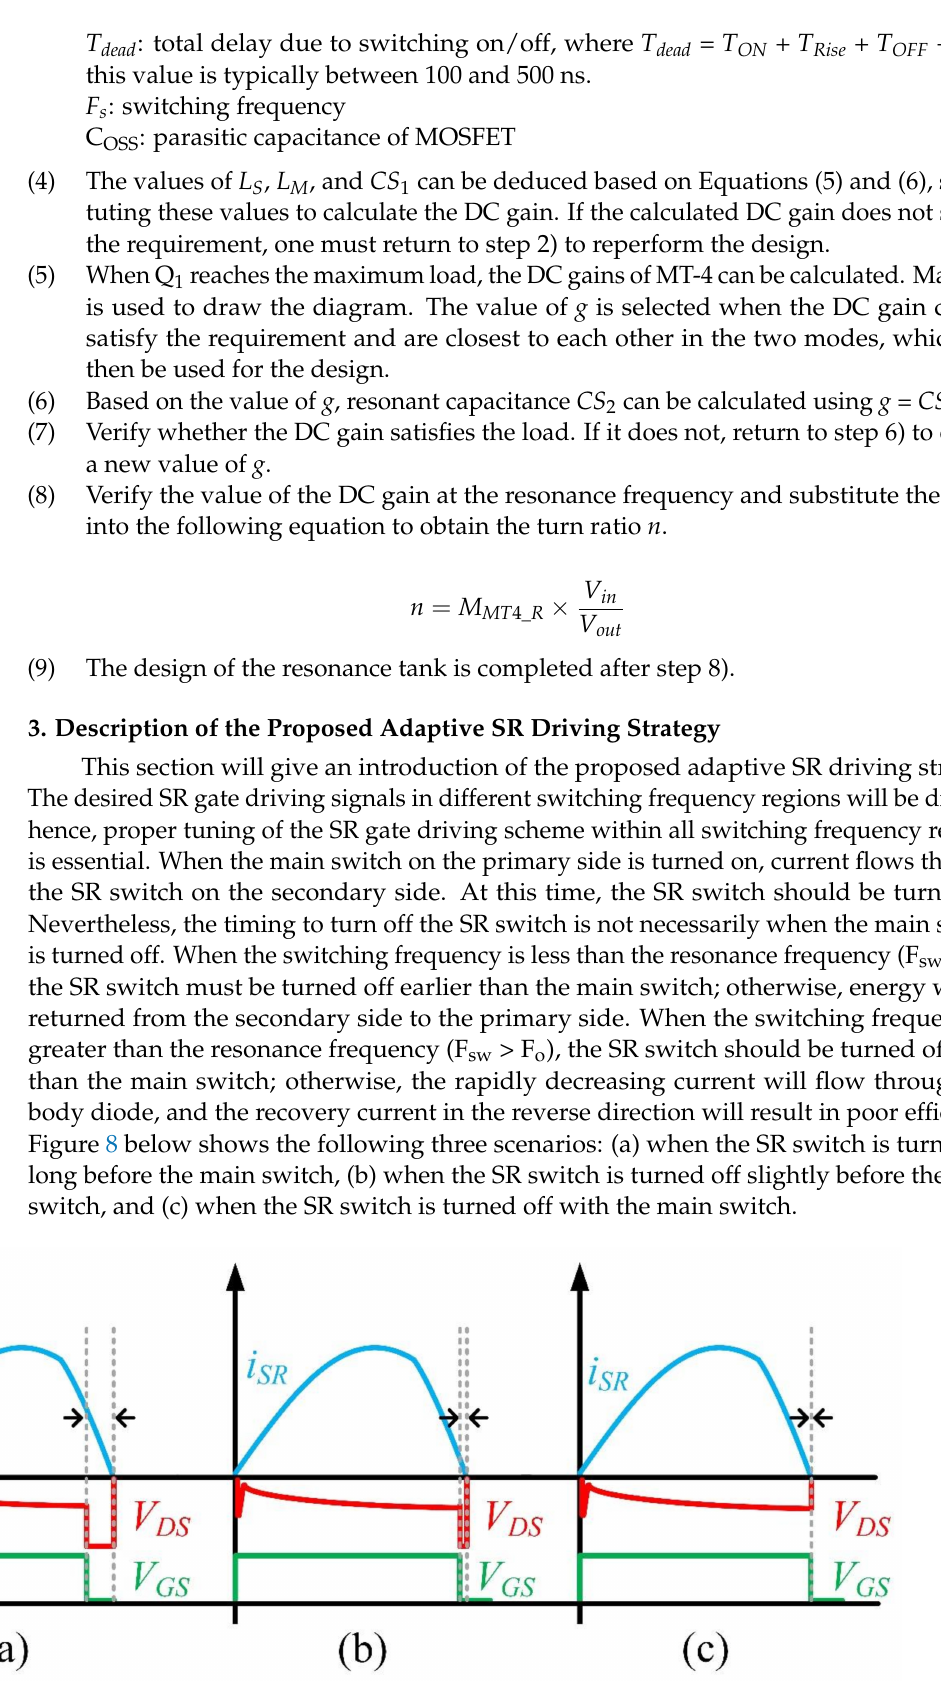
Figure 8. Concepts of different timing to turn off the SR switch ( a ) long before the main switch, ( b ) slightly before the main switch, and ( c ) with the main